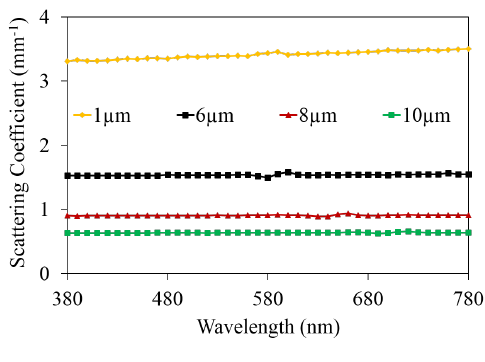
Fig. 2: The computed scattering coe(cid:30)cients of Ca 2 MgSi 2 O 7 :Eu 2+ phosphor as a function of size.